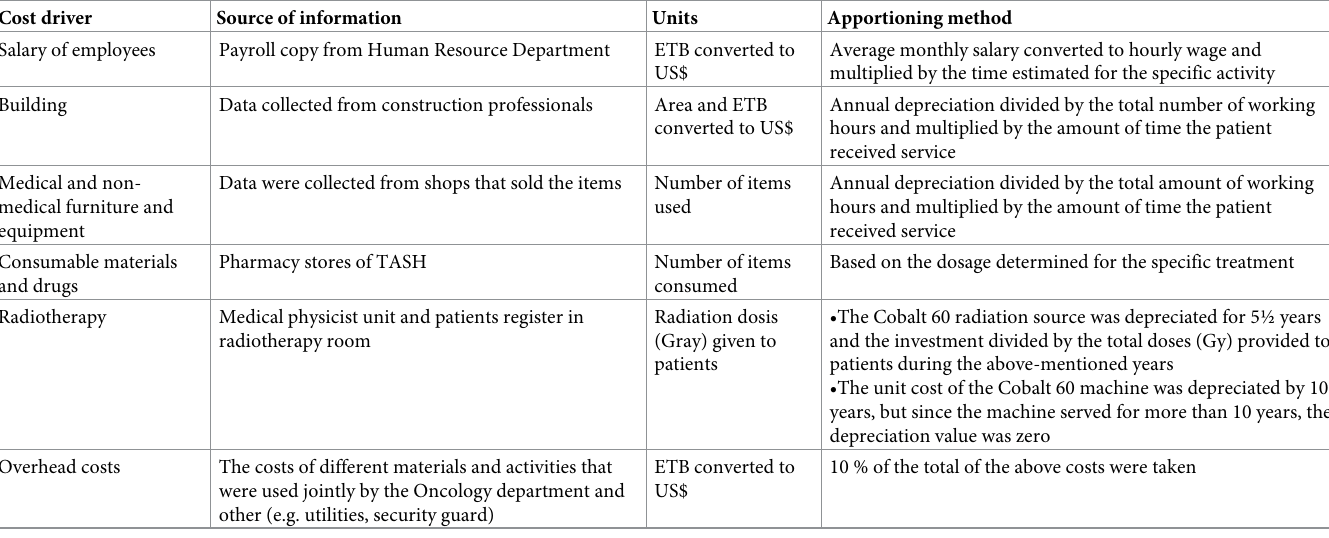
Table 1. Sources of data and apportioning method for estimating the unit of cost of each cost